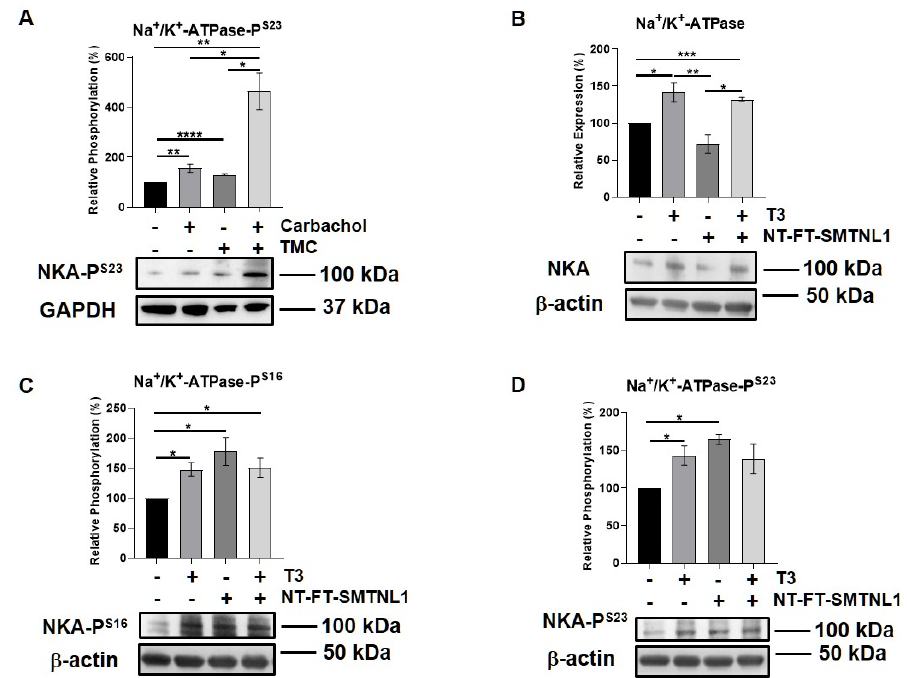
Figure 7. T 3 Treatment and SMTNL1 overexpression influence the expression and phosphorylation of Na + /K + -ATPase in myotubes. ( A ) Plantaris muscle strips of mice were treated with 10 µM TMC for 30 min followed by 10 µM carbachol for 10 min. Samples were lysed and subjected to Western blot using anti-Na + /K + -ATPase. ( B – D ) Myoblasts were transfected with empty vector or NT-FT- SMTNL1 and were differentiated in parallel with a 72-h T 3 treatment started from Day 4. Proteins from whole-cell lysates were separated by size and were analyzed using Western blot with anti- Na + /K + -ATPase ( B ), anti-Na + /K + -ATPase-P S16 ( C ) and anti-Na + /K + -ATPase-P S23 ( D ). Values represent